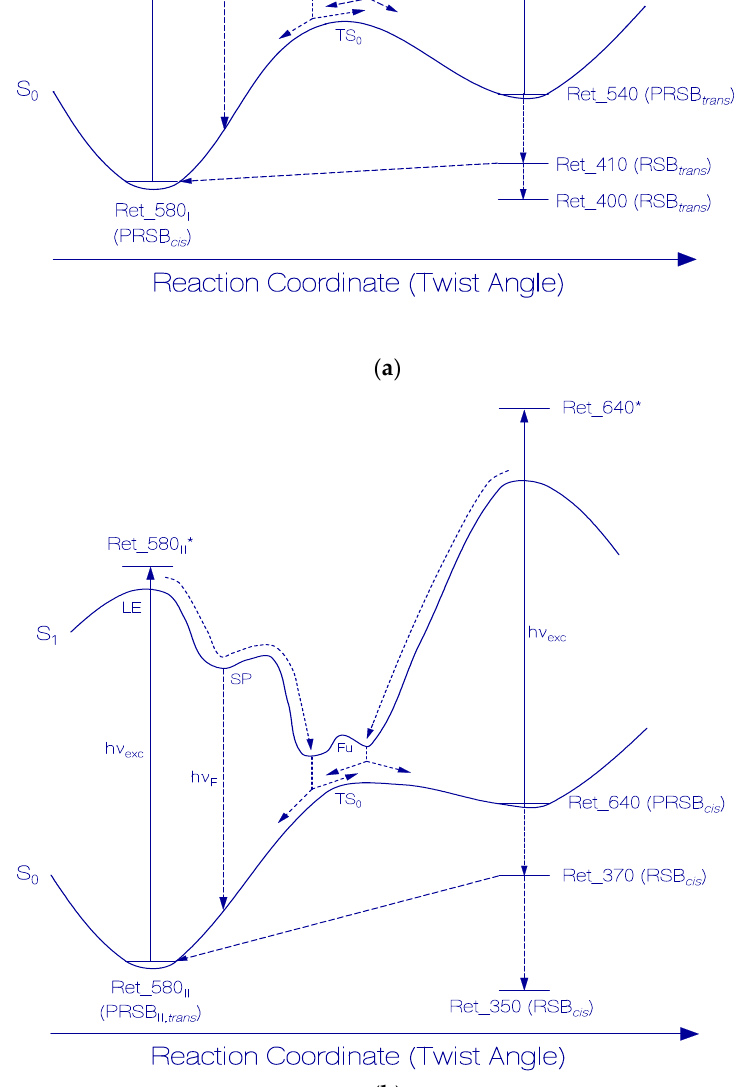
Figure 7. Schematic reaction coordinate diagrams for Ret_580 I ( a ) and Ret_580 II ( b ) photocycles of QuasAr1 in pH 8 Tris buffer.